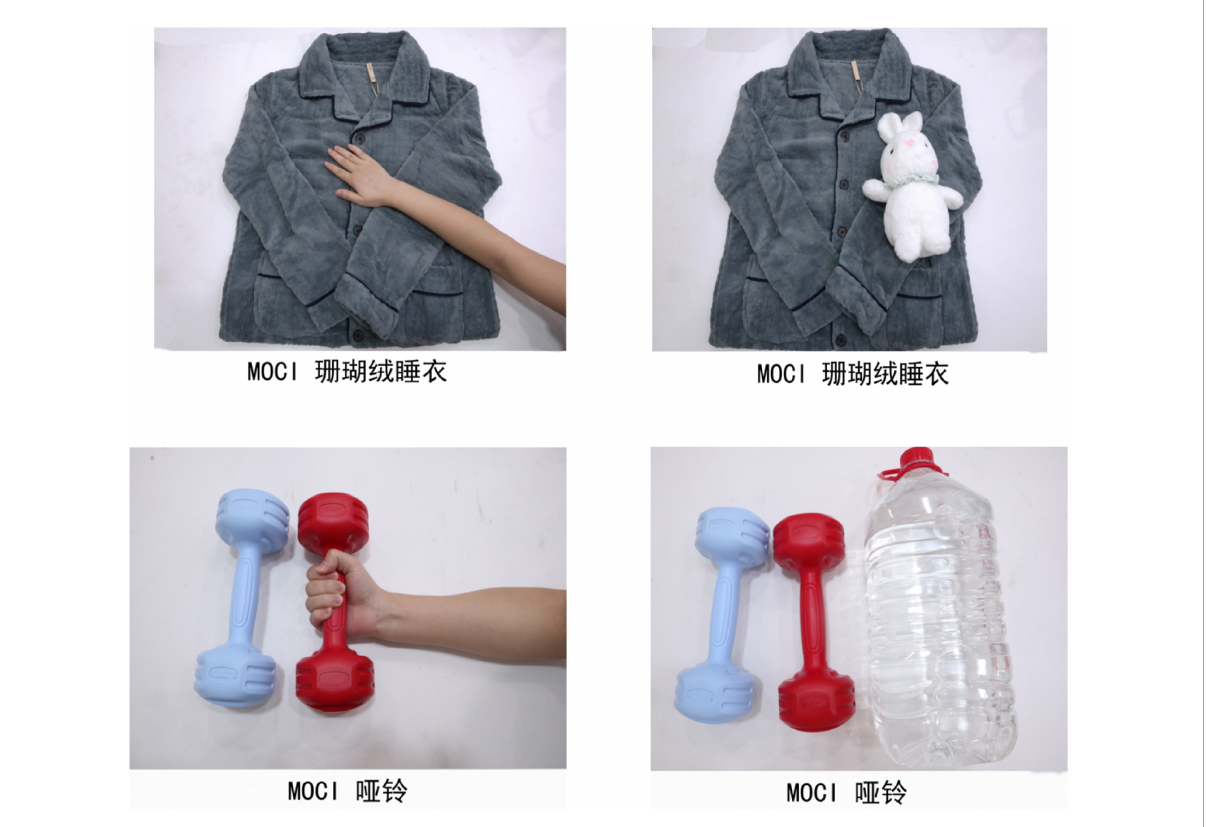
FIGURE4 Study 3 stimulus